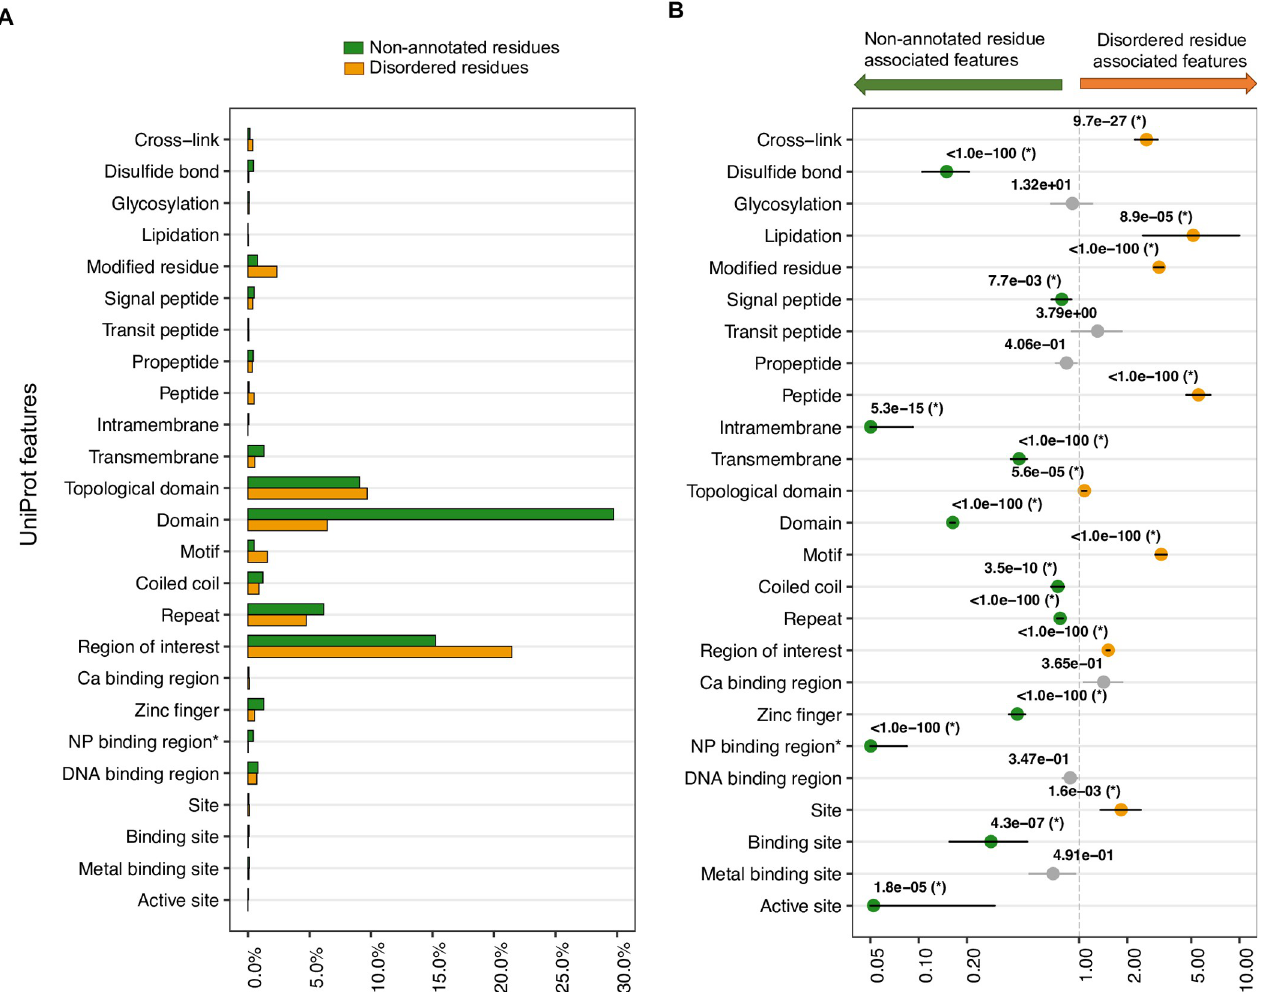
Fig 1. Some UniProt features are more frequent in disordered regions of proteins compared to non-annotated regions. ( A ) Distribution of disordered (total = 58,993) and non-annotated residues (total = 286,113) in 561 IDPs with twenty-five UniProt features. ( B ) Results of statistical association tests (two- tailed Fisher’s Exact test) between UniProt features and disordered residues compared to the non-annotated residues. Circles show the odds ratios (ORs) and are labelled with the corrected p-values ( q ), showing the significance of the association (a value of q < 1.0e-100 indicates the maximum significance, see Materials and Methods ). Horizontal bars show the 95% confidence interval (CI). The OR > 1.0 and OR < 1.0, along with q < 0.05, indicate the disordered residue-associated or DR feature (orange circle) and non-annotated residue-associated or NR feature (green circle) feature (y-axis), respectively. The vertical dashed line at OR = 1.0 indicates no association between a residue type (DR or NR) and a feature. To facilitate the visualization, minimum and maximum values of OR along the x-axis are set to 0.05 and 10.0, respectively. Non-significant associations ( q � 0.05) are indicated by gray CI bars and circles. NP binding region � indicates “Nucleotide phosphate binding